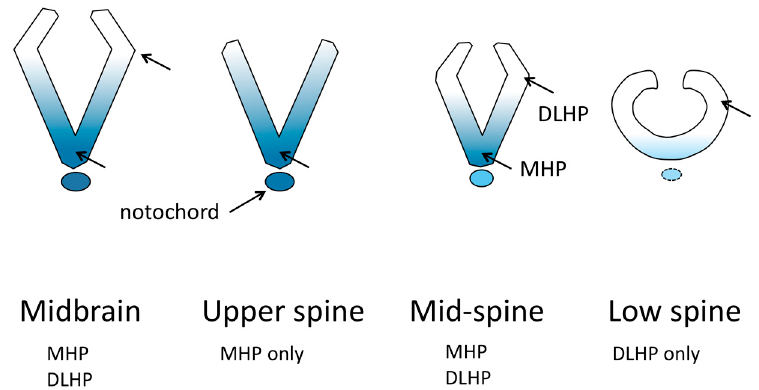
Figure 2. Conceptual views of the shape of neuroepithelium in transverse sections, at various anterior–posterior locations, of a mouse neural tube before closure, demonstrating differences in bending mechanisms. Shading represents the concentration of Shh signaling. DLHP, dorsolateral hinge point. MHP, medial hinge point. Modified from Figure 3 in [13].